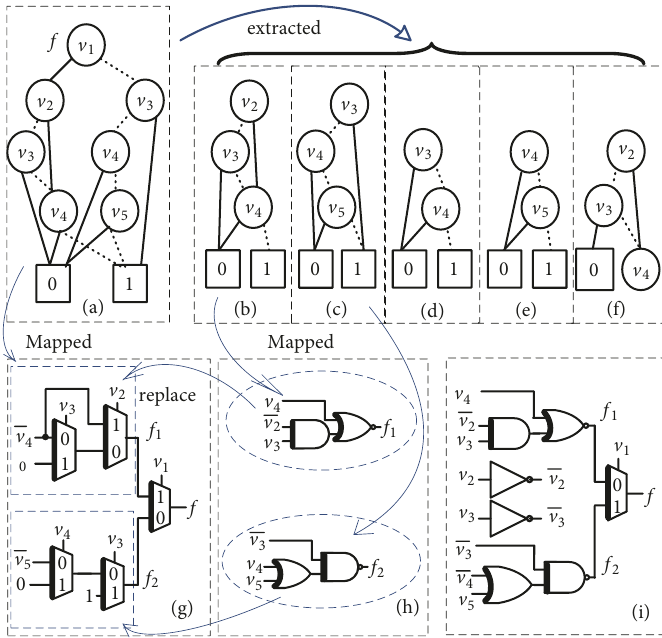
Figure 2: (a) A BDD example representing the Boolean logic equation (1), (b)–(f) its extracted BDD subgraphs, (g) MUX realization directly from (a), (h) the AOI and OAI cells mapped by the extracted BDD subgraphs (e), and (f), (i) the optimized result.